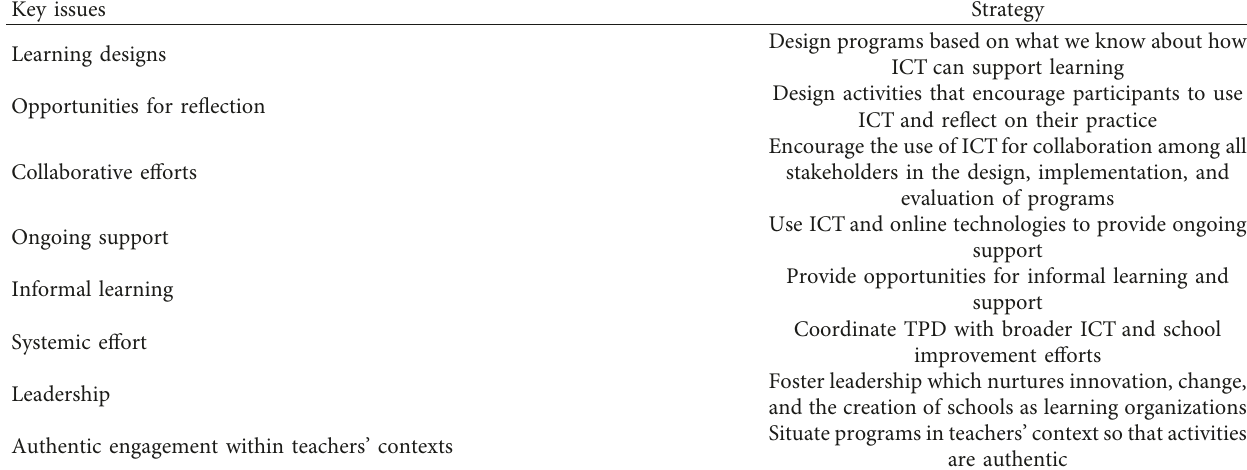
Table 2: A summary of key issues and strategies related to ICT for effective professional development. Key issues